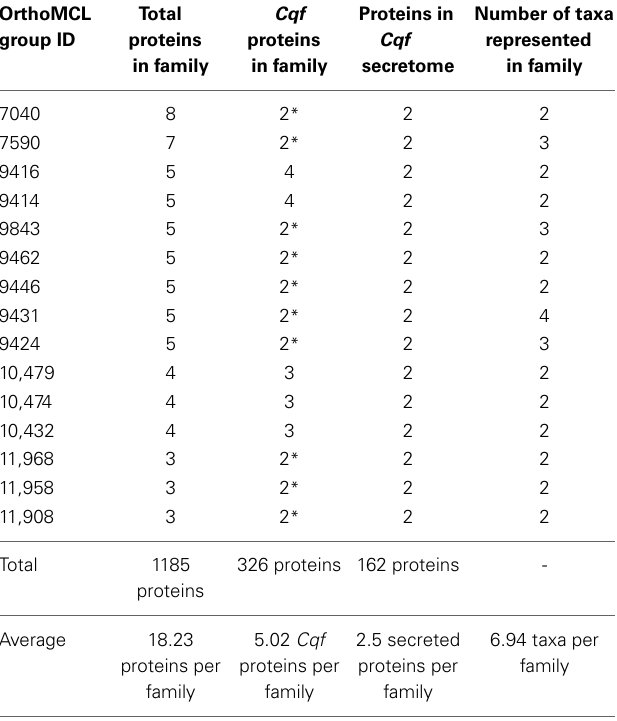
Table 1 | Conserved putative effector families have broad and narrow taxonomic